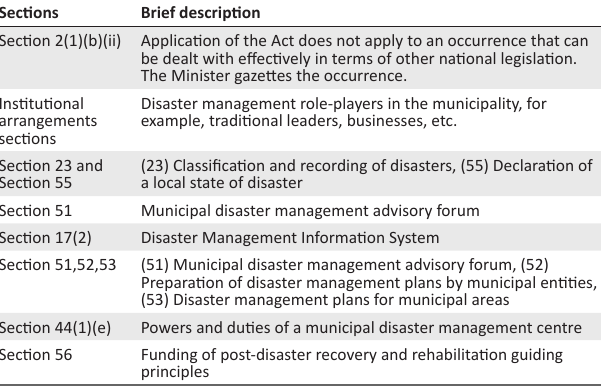
TABLE 3: Problematic sections in the legislation.